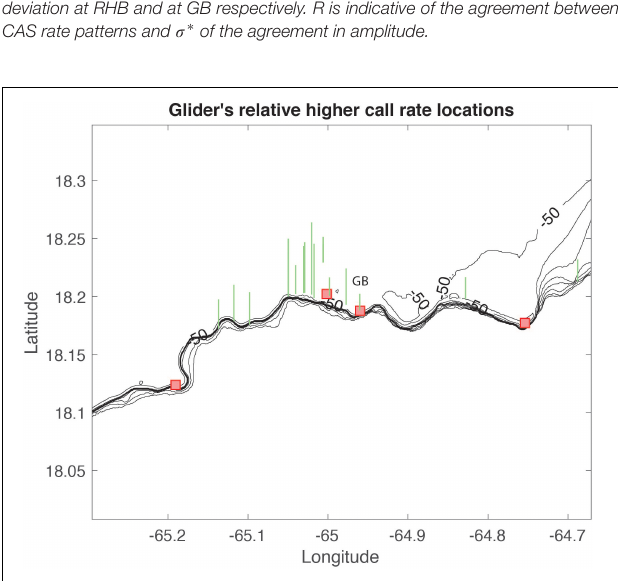
FIGURE 11 | Potential spawning habitat locations derived from the wave glider data as indicated by the green vertical bars. The length of each bar is relatively proportional to the CAS rate at each